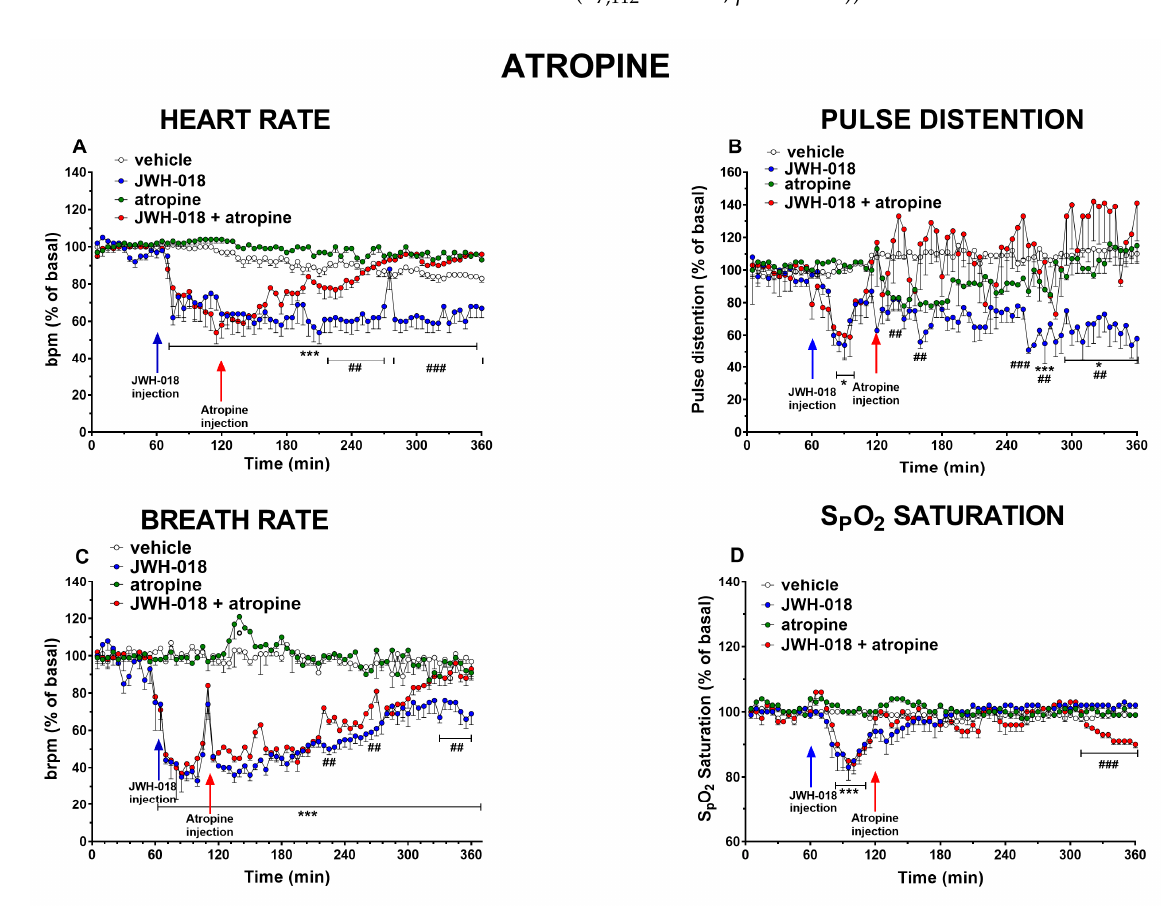
increased pulse distension in pretreated JWH-018 mice during the first and the last two p = 0.3015), and time × treatment interaction (F 213,1872 = 1.415, p = 0.0002)). On BR